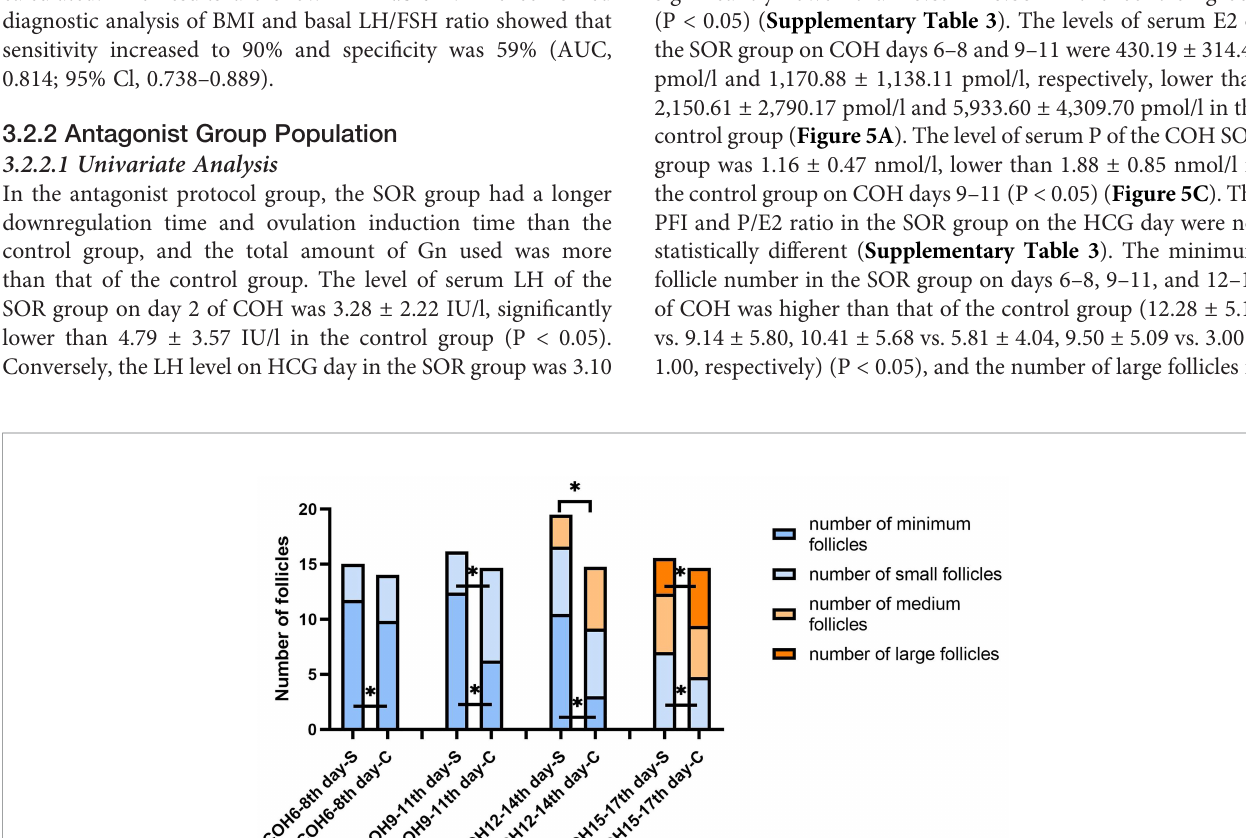
FIGURE 4 | Changes in the number of follicles of different sizes during the COH process in the ultra-long/long group patient (note (1): *Indicates statistically signi fi cant difference (P < 0.05); (2) S:SOR group; C: control group; (3) n (SOR group) = 71, n (control group) =